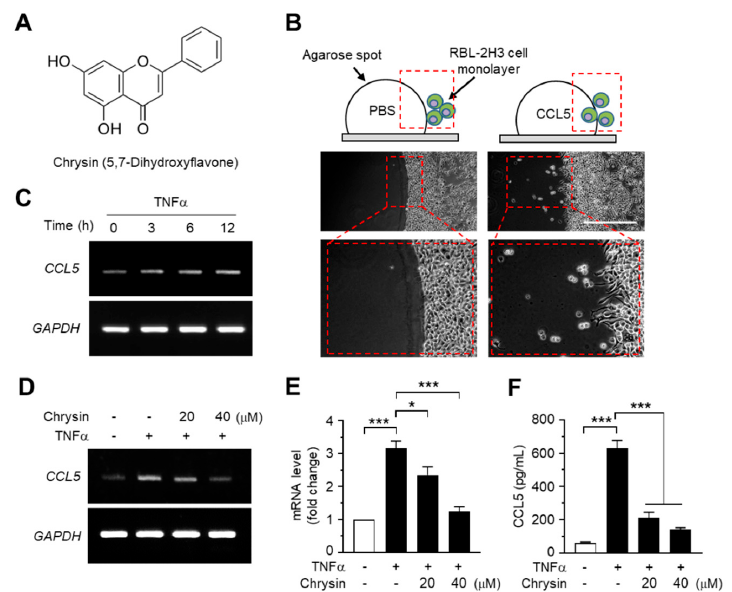
Figure 1. Effects of chrysin on the inhibition of C-C motif chemokine ligand 5 (CCL5) expression. ( A ) Chemical structure of chrysin (5,7-dihydroxyflavone). ( B ) Agarose spot migration